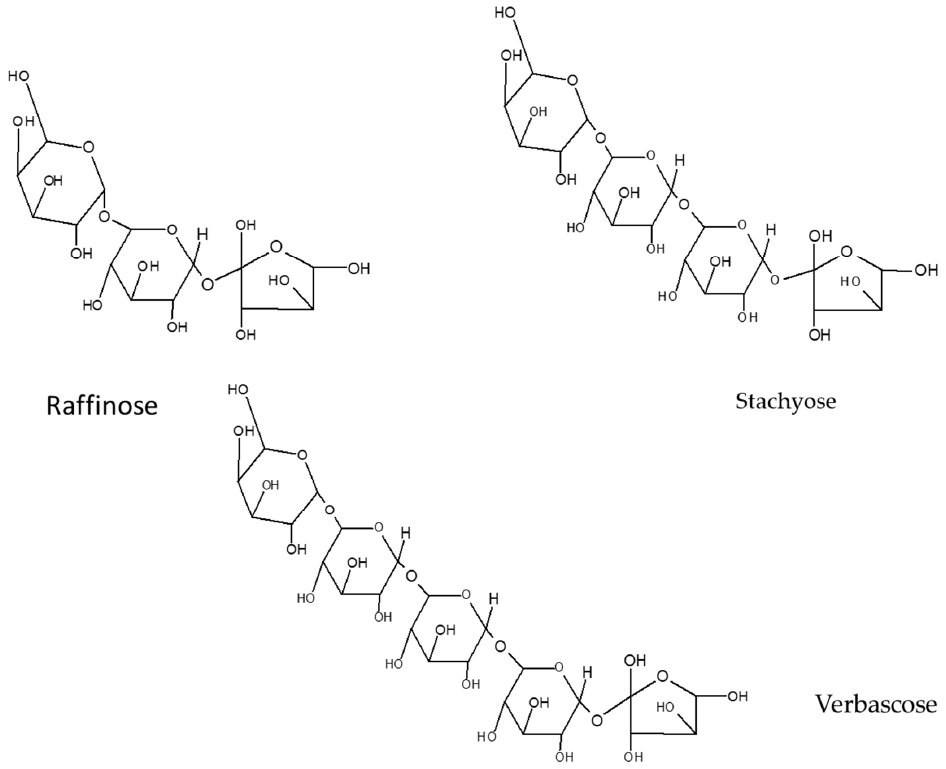
Figure 6. Raffinose family oligosaccharides structures. Figure 6. Ra ffi nose family oligosaccharides